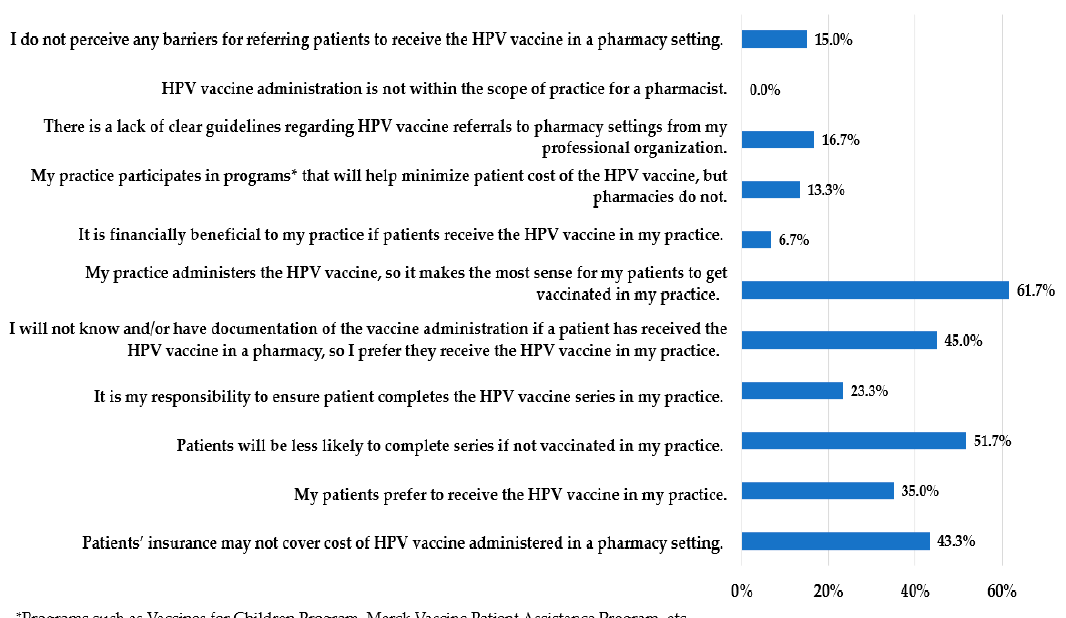
Figure 2. Perceived barriers to providers referring patients for HPV vaccination at community pharmacies. Each bar presents the percentage of respondents that indicated the barrier listed was a barrier for referring patients for HPV vaccination at a community pharmacy. The total percentage summed from all bars exceeds 100% because this survey question was a “mark all that apply” format question.